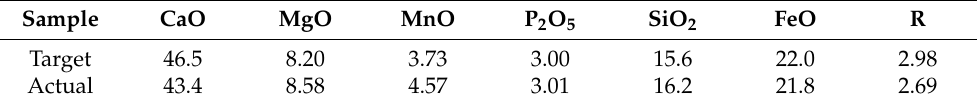
Table 1. Target and actual compositions of decarburization slag